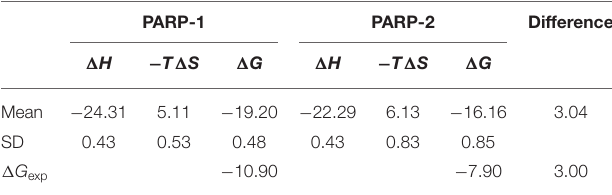
TABLE 1 | Overall binding free energy of NMS-P118 with PARP-1 and PARP-2 using the MM/GBSA_IE method. PARP-1